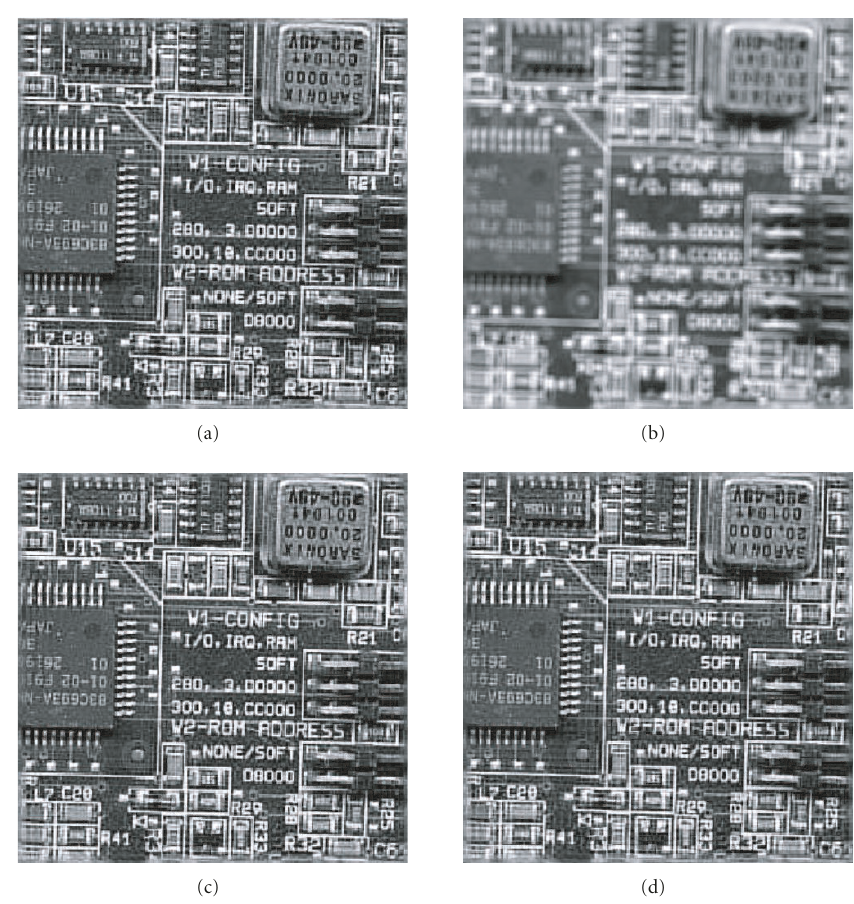
Figure 2: Multichannel blind image restoration results. (a) Original “Board” image. (b) A sampled blurred image out of the four degraded images. (c) Restored image using the proposed MRF algorithm with identity regularization operator. (d) Restored image using the proposed MRF algorithm with Laplacian regularization